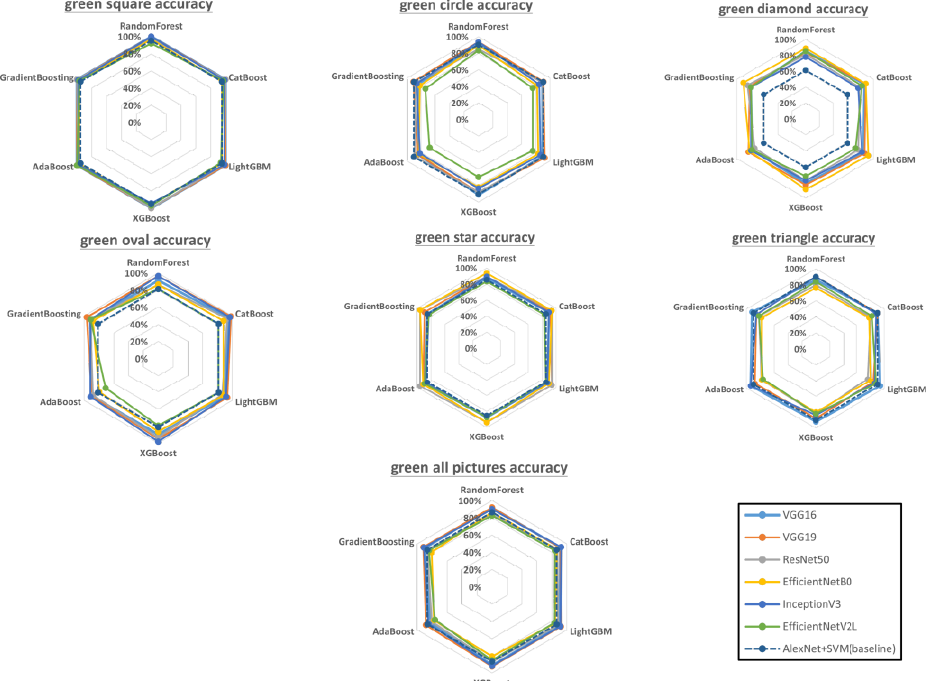
Figure 11. Accuracy of each model combination for green-colored geometries (raw data are presented in Appendix B). The dotted regular hexagon is the baseline using AlexNet with SVM.